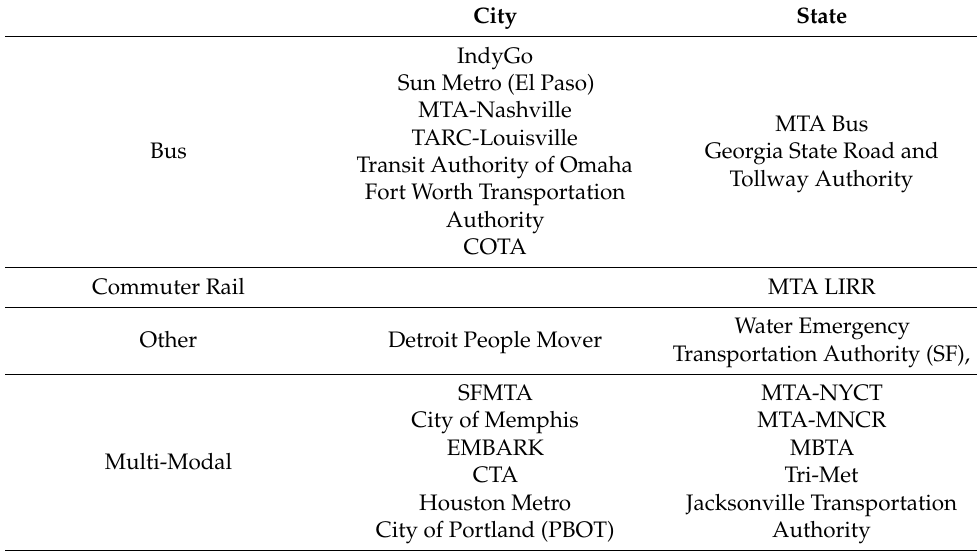
Table 2. Public Authority Governance by Level of Control and Mode.